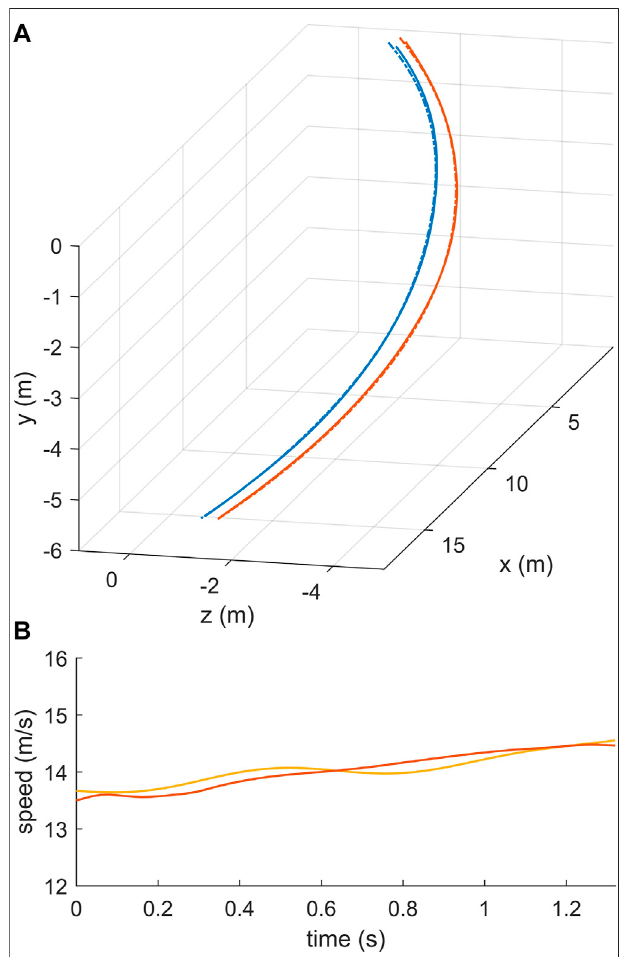
FIGURE 3 | Comparison of the optimized track of the skier in the turning simulation (solid lines) and the corresponding measurement data (dashed lines) in (A) (B) shows the measured (solid red) and optimized speed (solid yellow) of the